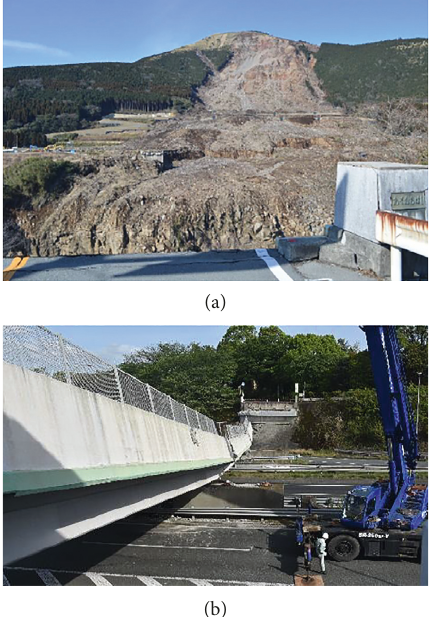
Figure 4: The collapse of (a) Aso Bridge and (b) Furyo First Bridge.